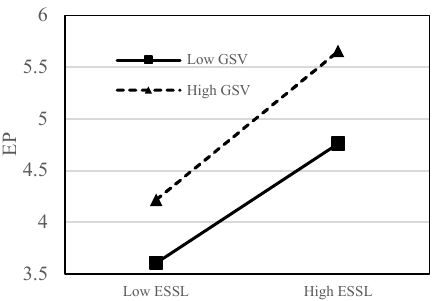
Figure 4. The moderating effect of GSV on the relationship between ESSL and EP.